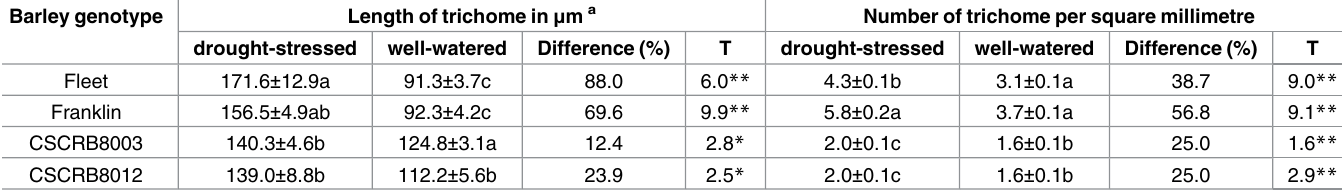
Table 2. Effects of drought on trichome traits measuredon drought-stressed and well-watered seedlings at 14 days post inoculation. Barley